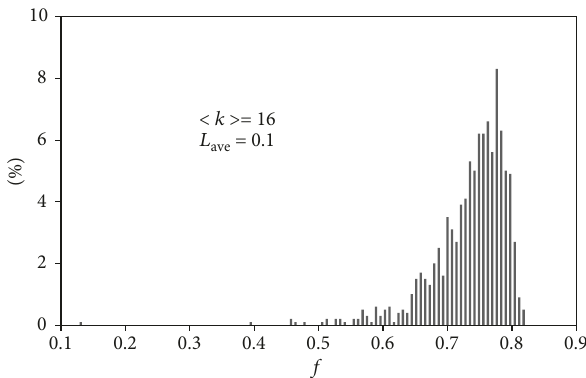
Figure 2: The distribution of the degree of individual infection in a random network with < k > = 16 , L ave = 0 1 , and r